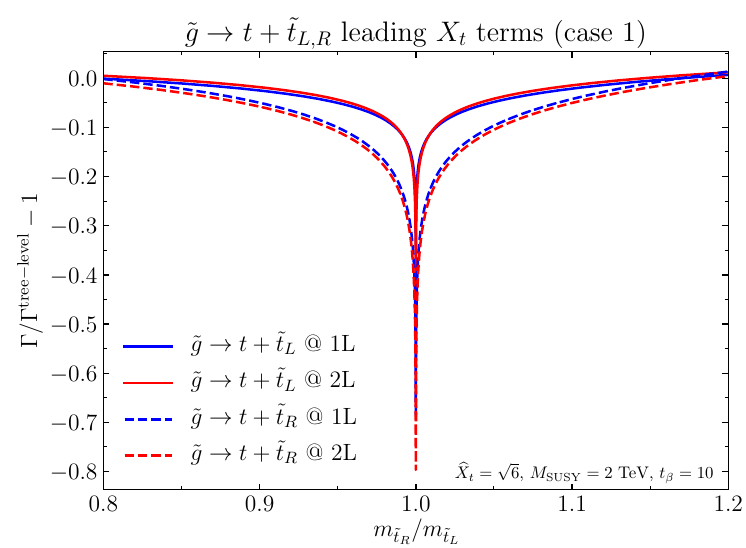
/m ˜ , where the final state t R t L